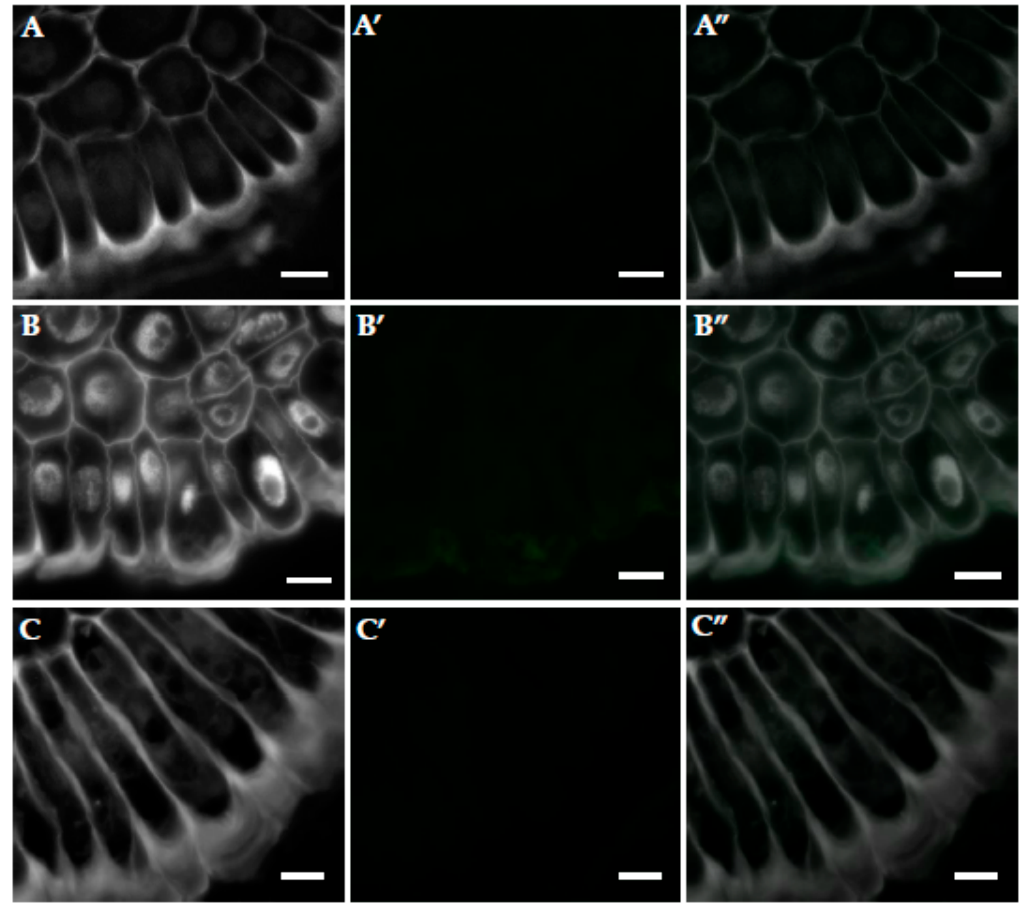
Figure A2. The example of the negative control for the immunolocalization of pectin epitopes in cross sections in differentiated zone of root tissues of barley cv. Sebastian. ( A )—control pH 6; ( B )—control pH 4; ( C )—30 µM AlCl 3 . Calcofluor (CF) and DAPI staining ( A – C ), no primary antibodies in immunolocalization reaction were used ( A’ – C’ ) and merged CF and DAPI staining with negative control are shown ( A” – C” ). Representative sections are shown.